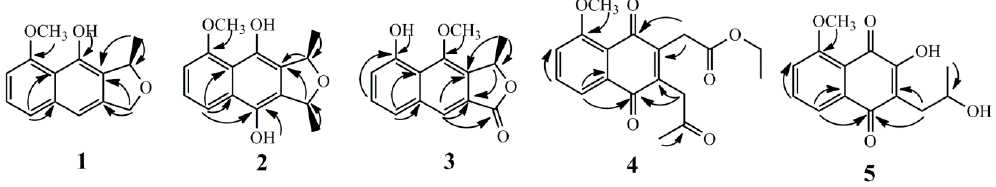
Figure 2. Key HMBC correlations of compounds 1 – 5 .